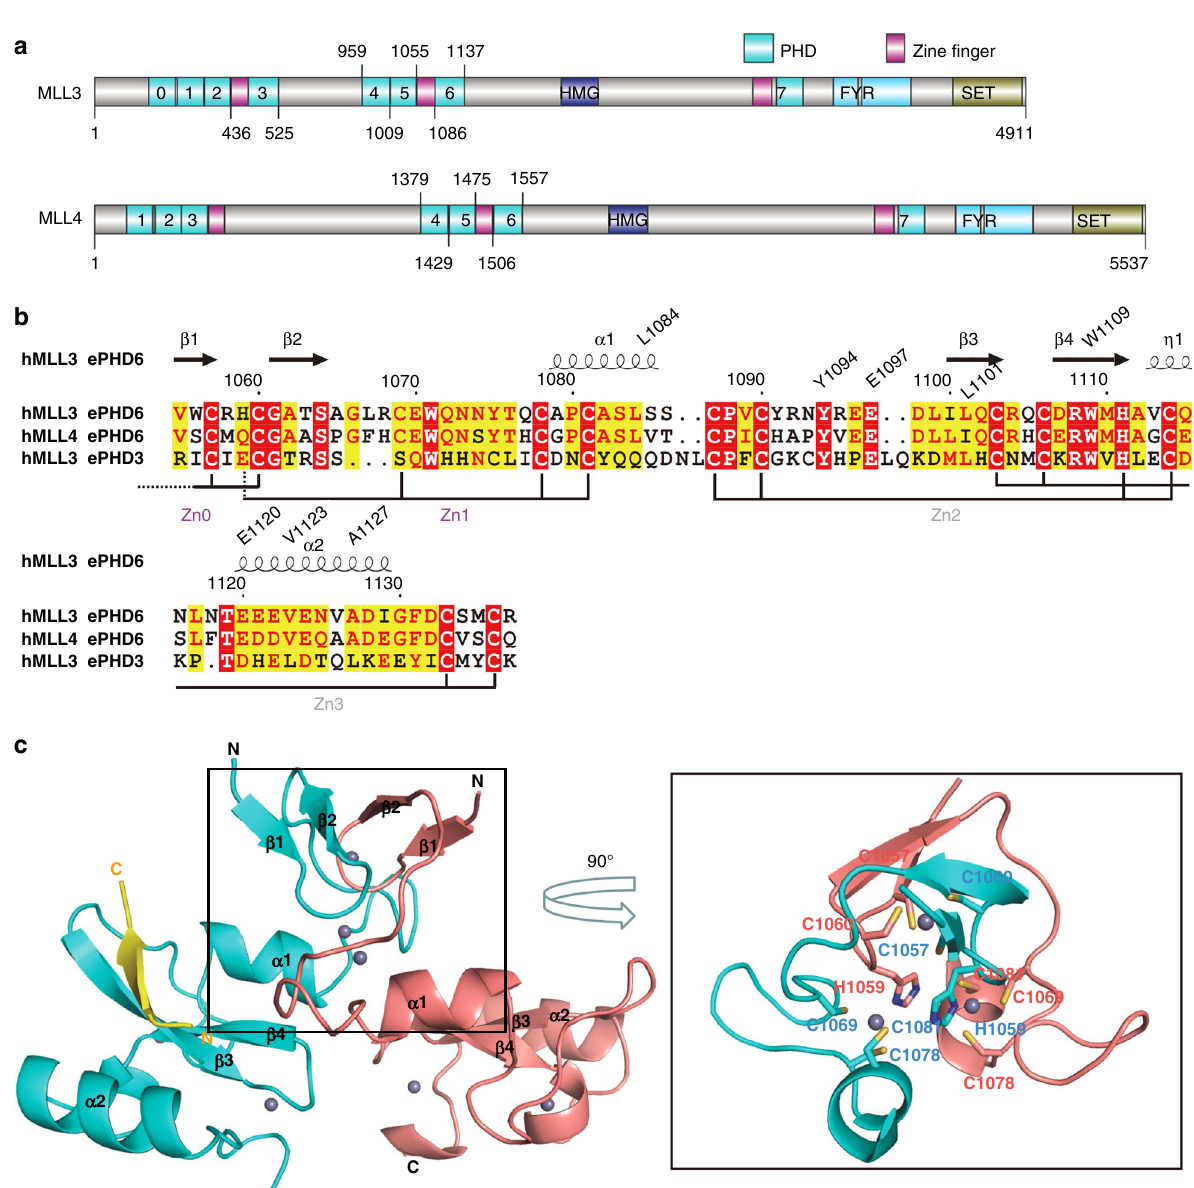
Fig. 1 Overall structure of the extended PHD 6 domain of MLL3 in complex with the H4H18 peptide. a Domain structure of human MLL3 and MLL4. PHD: plant homeodomain-linked zinc fi nger; SET: the histone methylation catalytic domain; HMG: high-mobility group; FYR: phenylalanine and tyrosine rich domain. b Structure-based sequence alignment of the extended PHD domains 3 and 6 of MLL3 and the extended PHD domain 6 of MLL4. Secondary structure elements and residue numbers of the ePHD 6 domain of MLL3 are indicated above the sequence alignment. The alignments were constructed with ClustalW 56 and re fi ned with ESPript 57 . c Overall structure of the ePHD 6 domain of MLL3 in complex with H4 1-20 peptide. The two molecules of ePHD 6 domains are colored in cyan and salmon, respectively. Structure fi gures were generated by using